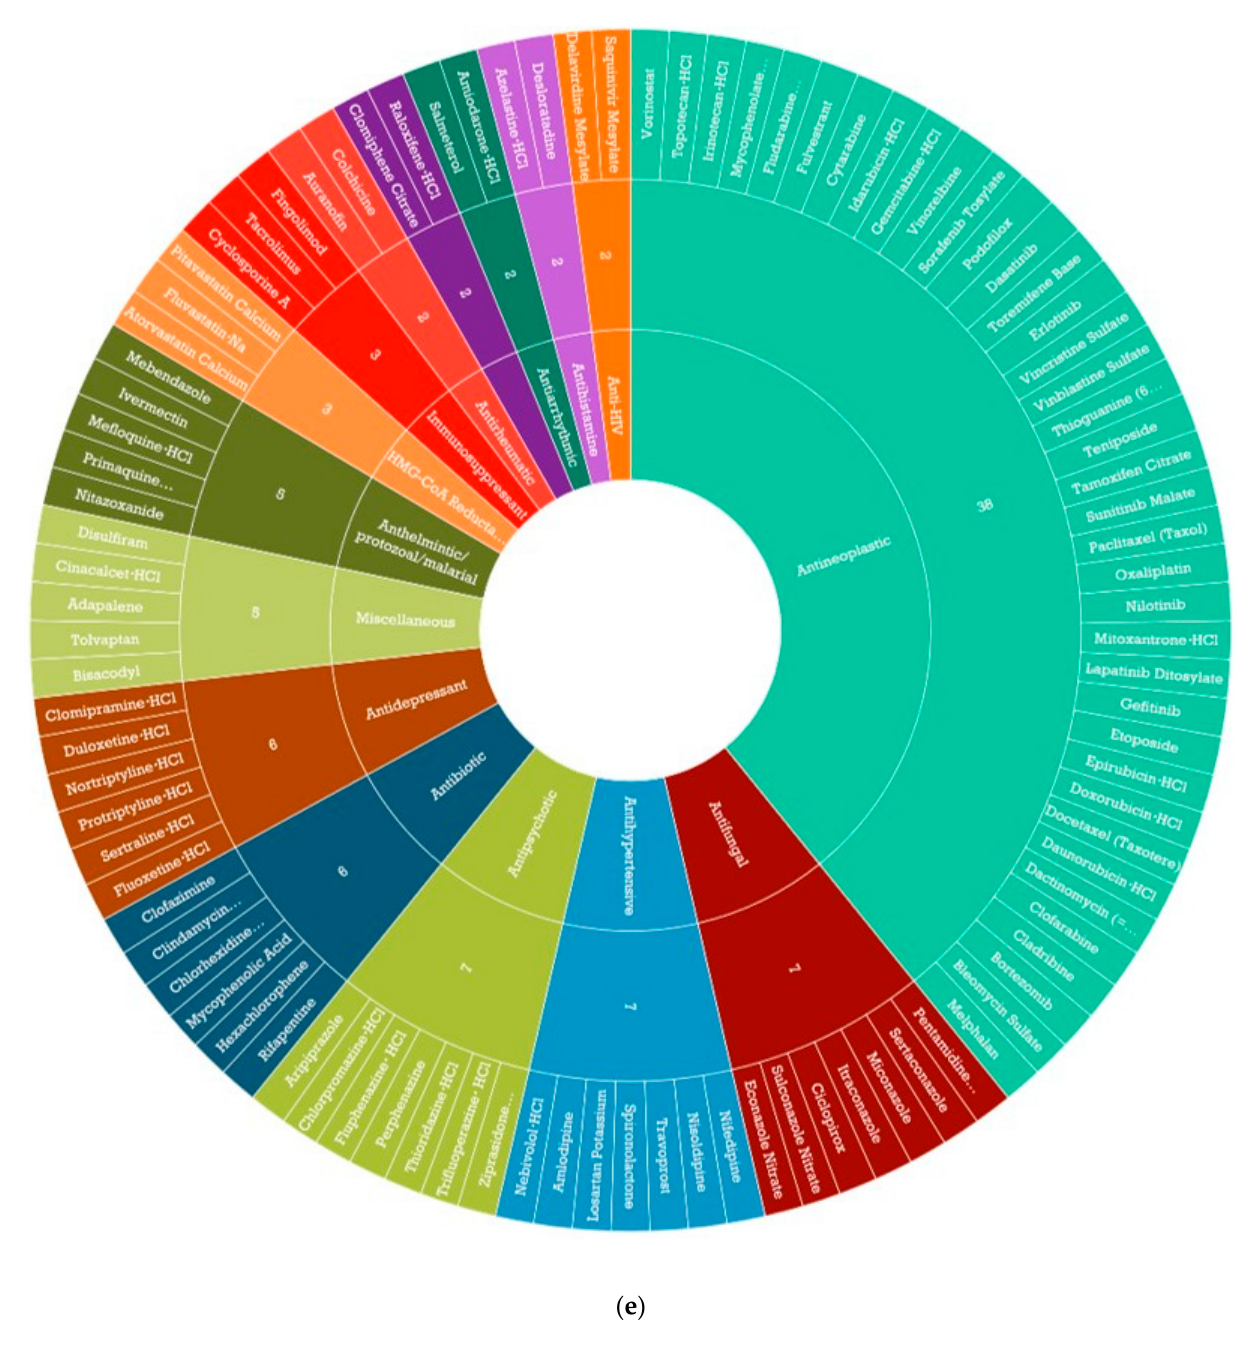
Figure 2. Positive hits identified by siRNA screening and the FDA-approved compound screen. ( a ) Positive hits from secondary siRNA screen were tested in ( a ) OE33, ( b ) FLO-1, ( c ) SKGT4, and ( d ) MFD1 cells. Cells were transfected with 10 nM siRNA for 24 h prior to 48 h treatment with ~IC 30(72 h) doses of CDDP or 5-FU. Viability was assessed by MTT. The results represent the mean ± SEM of triplicate experiments. Significance was assessed by Student’s t -test (* p < 0.05, ** p < 0.01, *** p < 0.001, NS, not significant). siNC, negative siRNA control; siDeath, positive siRNA control. ( e ) Drug class wheel representing 97 compounds that reduced OE33 or FLO-1 viability by ≥ 80%. Cells were treated with 1 µ M of each library compound and viability was assessed by CellTiterGlo ® at 72